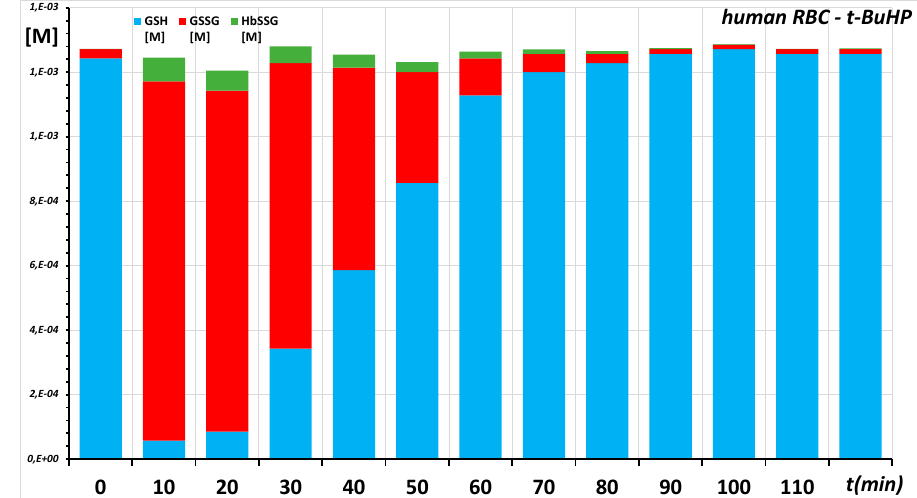
Figure A1. Partitioning of the glutathione pool during the RBC oxidative challenge experiment (same values of Table A1 and Figure 1), displayed as a cumulative bar graph of reduced glutathione (GSH), oxidized glutathione disulfide (GSSG) and HbSSG. All concentrations are expressed as glutathione equivalents and, therefore, the measured concentration of GSSG (red bar) shows twice as large. The total glutathione pool holds constant during the experiment, with a 1.26 × 10 − 3 M mean concentration (1.8% CV).